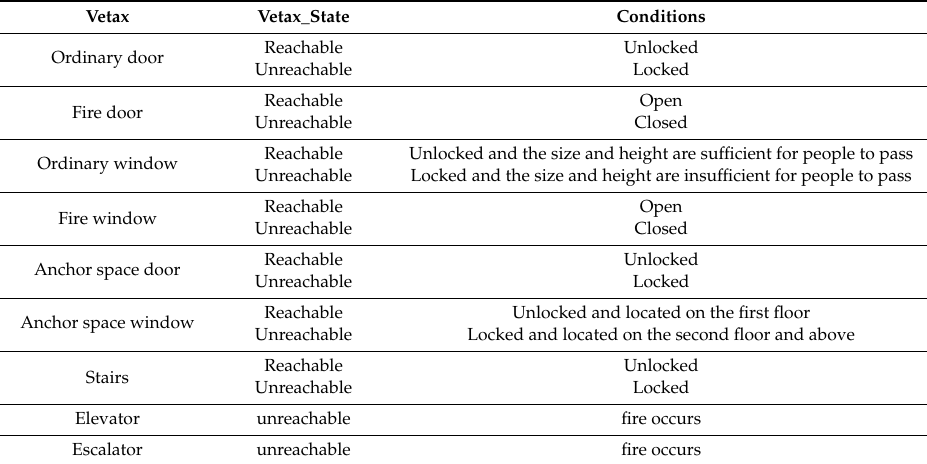
Table 1. Road network node state in an indoor fire